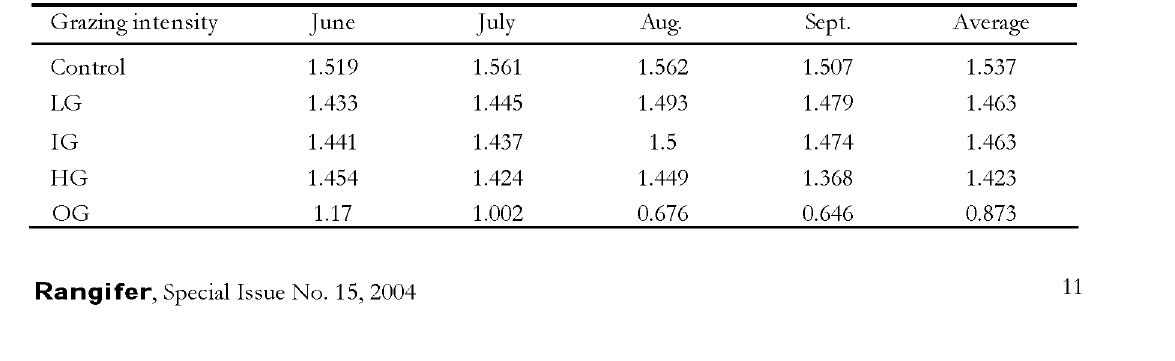
Table 1. Biodiversity change of Kobresia pygmaea meadow under different grazing intensities. Grazing